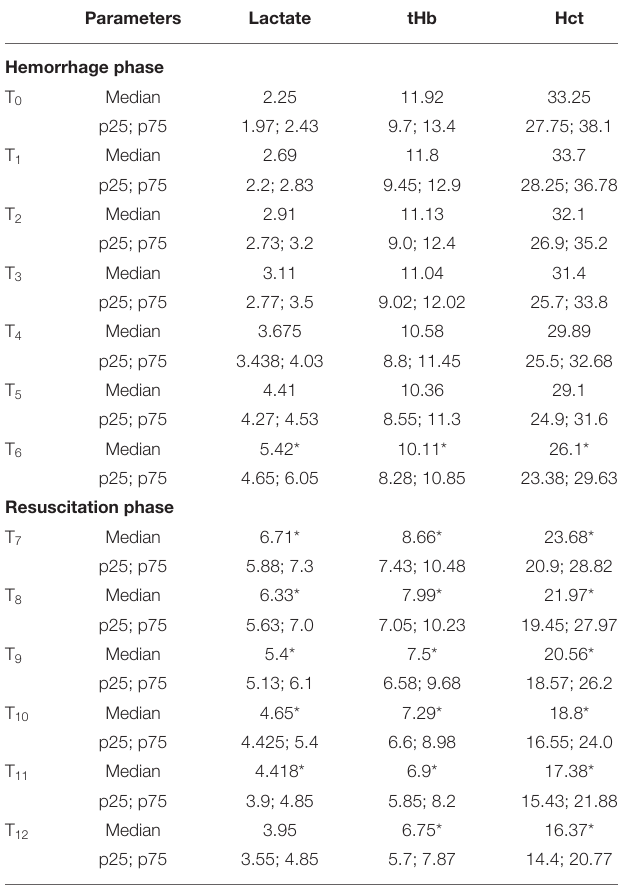
TABLE 1 | The effects of the hemorrhage and resuscitation phases on blood lactate (mmol L − 1 ), Hct (%), and tHb (g dl − 1 ).